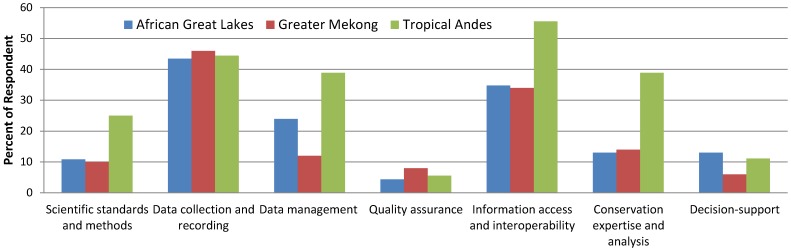
Perceived challenges to biodiversity monitoring by region.Number of respondent is 36 for Tropical Andes, 46 for African Great Lakes, and 50 for Greater Mekong.